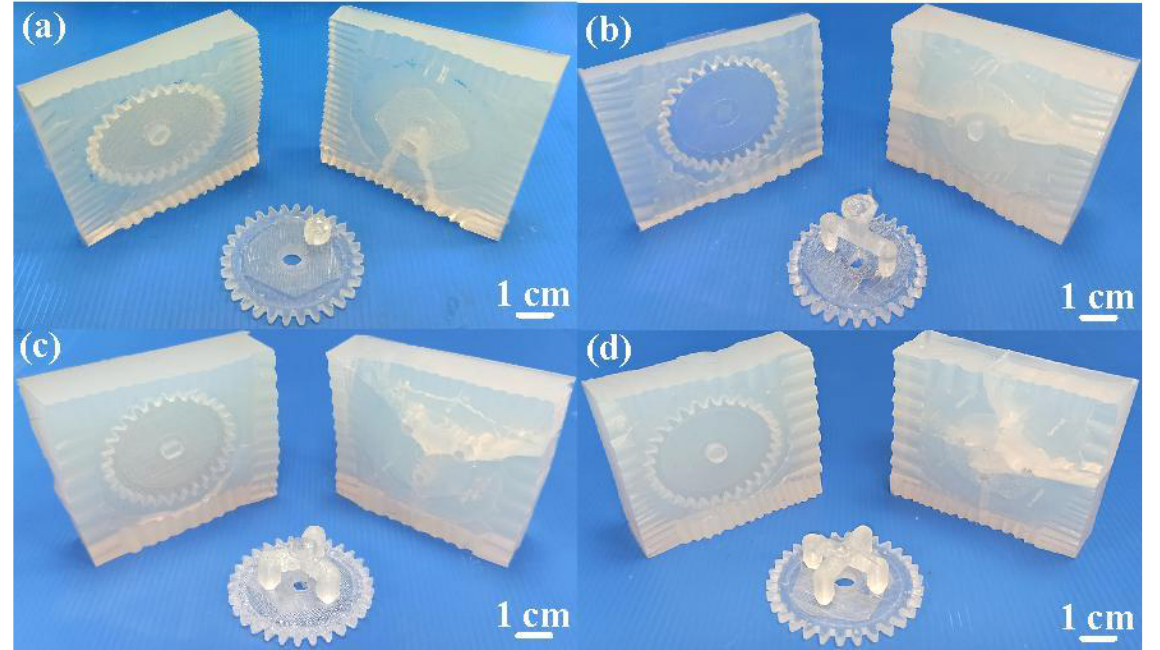
Figure 12. Silicone rubber molds for gate numbers of ( a ) single point, ( b ) two points, ( c ) three points, and ( d ) four points.